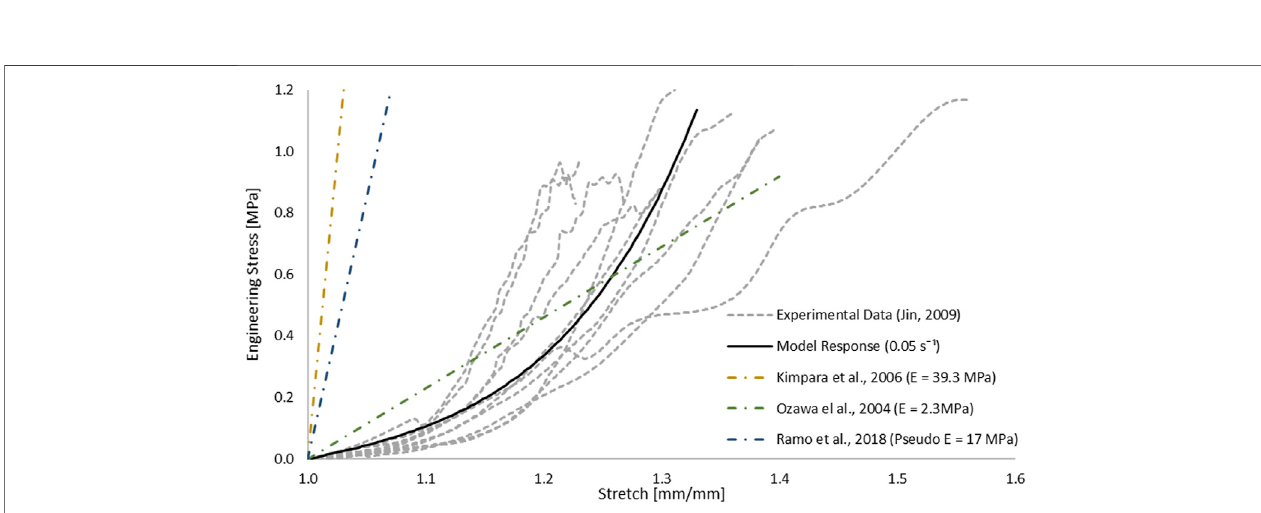
FIGURE 5 | Optimized response of the hyperelastic Ogden material model in a single element test case compared to tensile test data of the pia mater (Jin et al., 2006). Other strain-stress curves with different Young ’ s modulus reported in studies were presented.